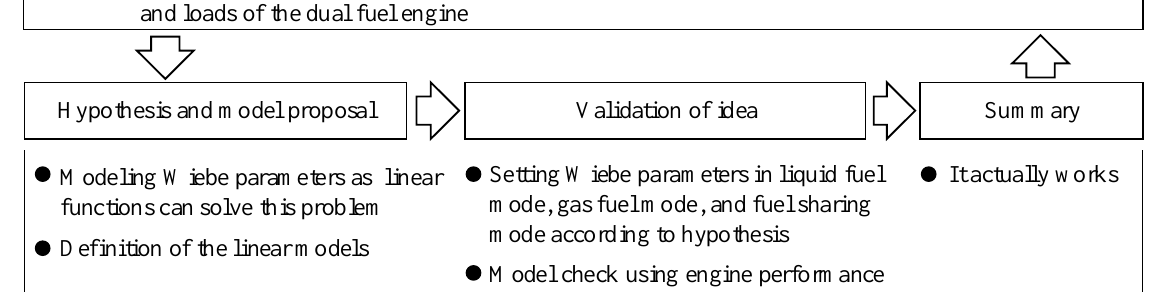
Figure 1. Overview of the idea and scheme.